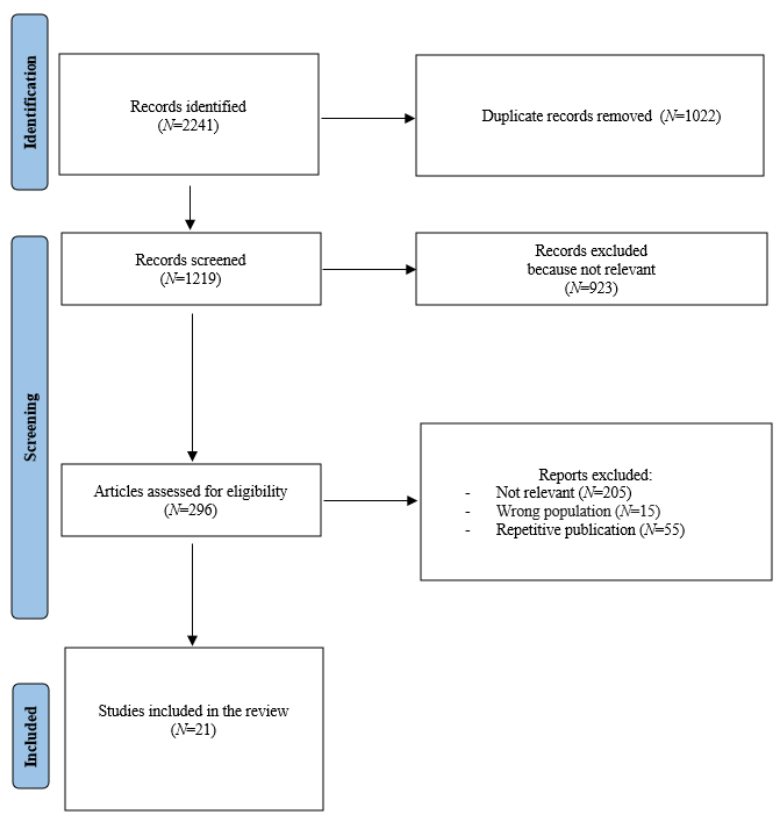
Figure 1. PRISMA flow diagram of selection of studies for inclusion in the review.